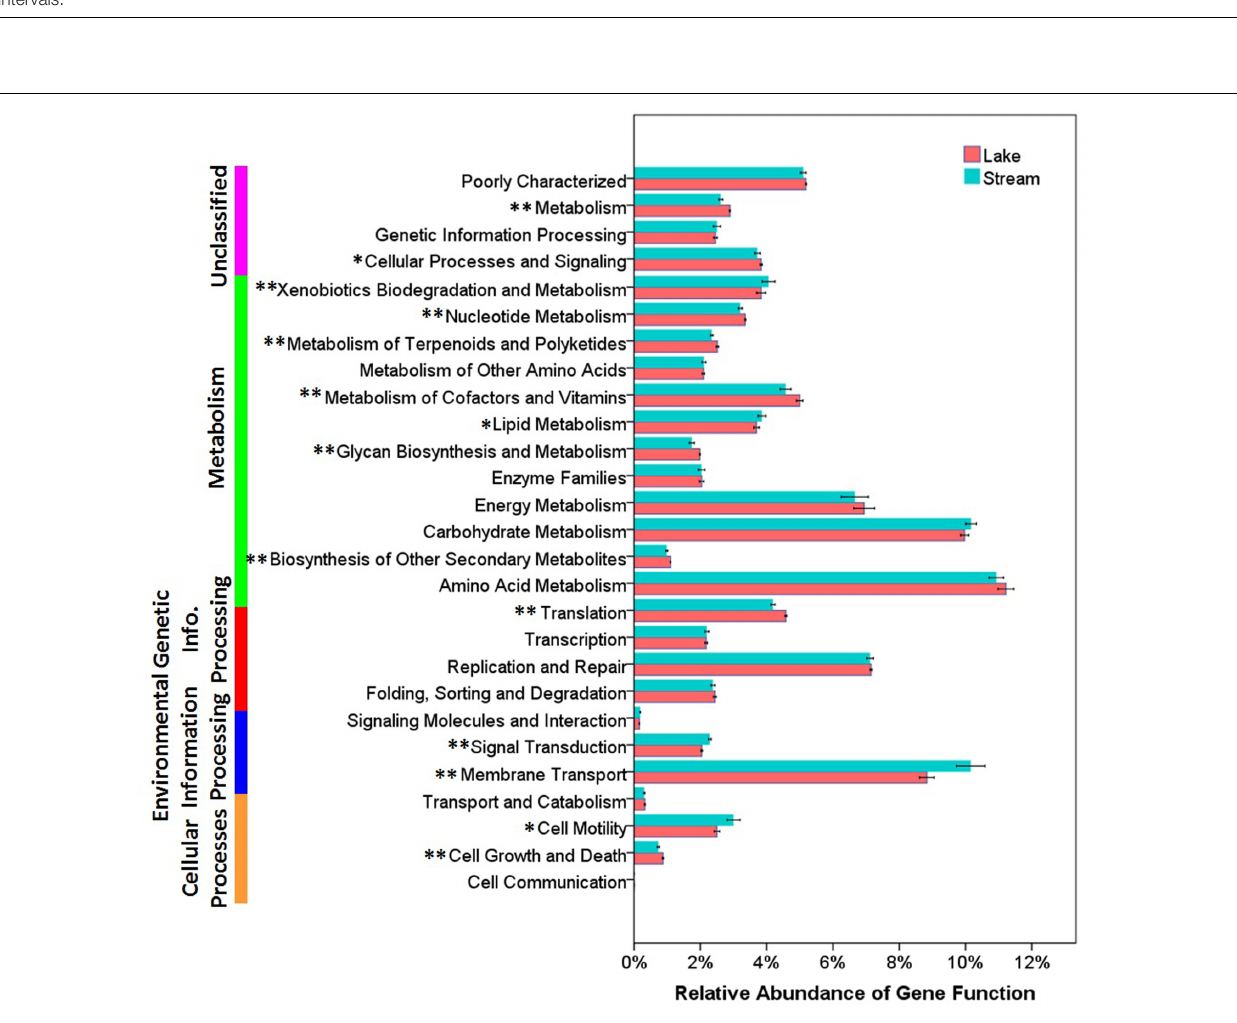
FIGURE 7 | The relative abundance of various predicted functions of microbial communities in lake water and stream biofilms using PICRUSt grouped into level-2 functional categories. ∗ and ∗∗ indicate gene categories that are different between lake and stream at the P < 0.05 level and P < 0.01 significant level, respectively.